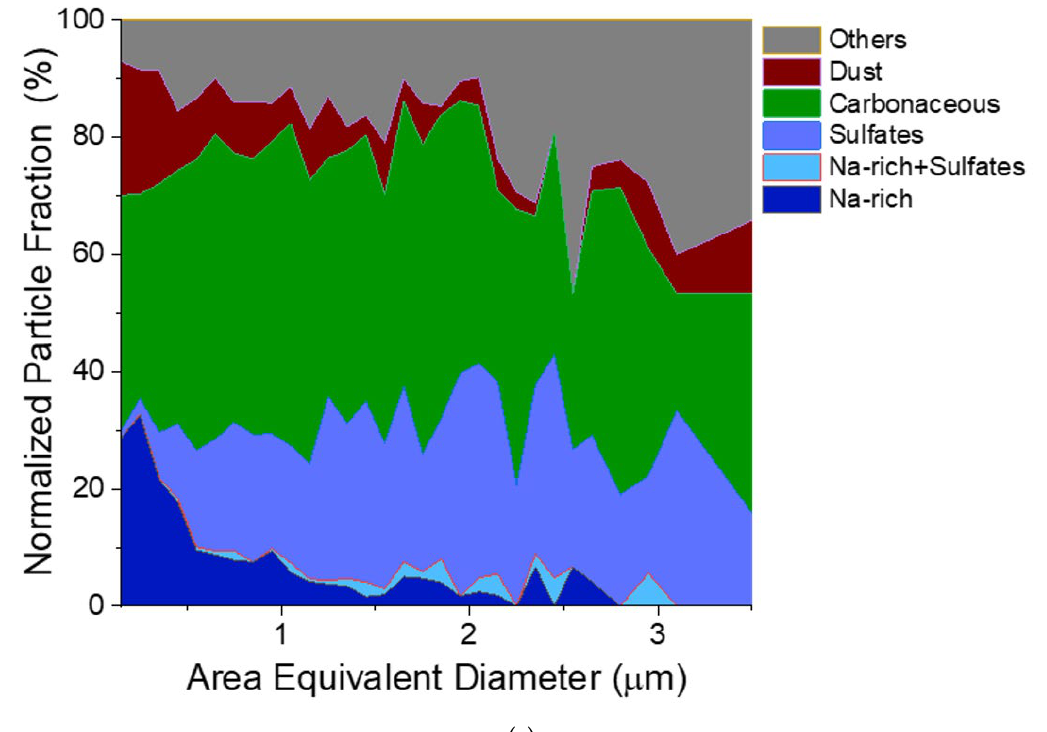
Figure 10. ( a ) The time series of the total concentration from the tethered balloon system (TBS) POPS and condensation particle counter (CPC) during the TBS flight on 26 July. ( b ) Aerosol size distribution plot of the biomass burning plume observed by the TBS POPS between 17:50 and 18:15 at 850 m. ( c ) Size-resolved chemical composition of particles collected between 17:50 and 18:15 at 850 m.